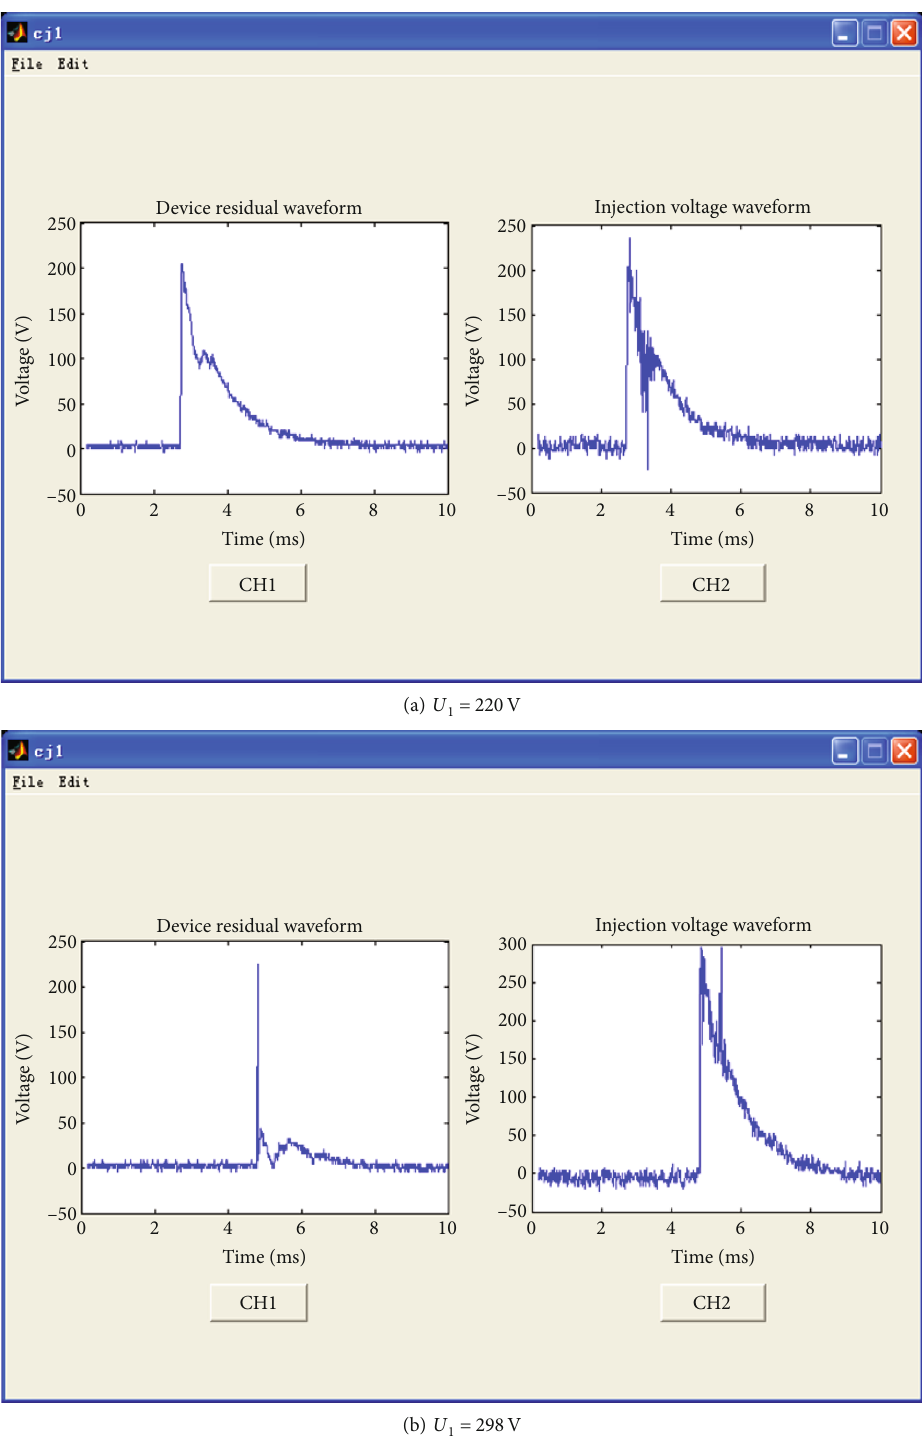
Figure 4: Response waveform of coaxial gas discharge tube to wide